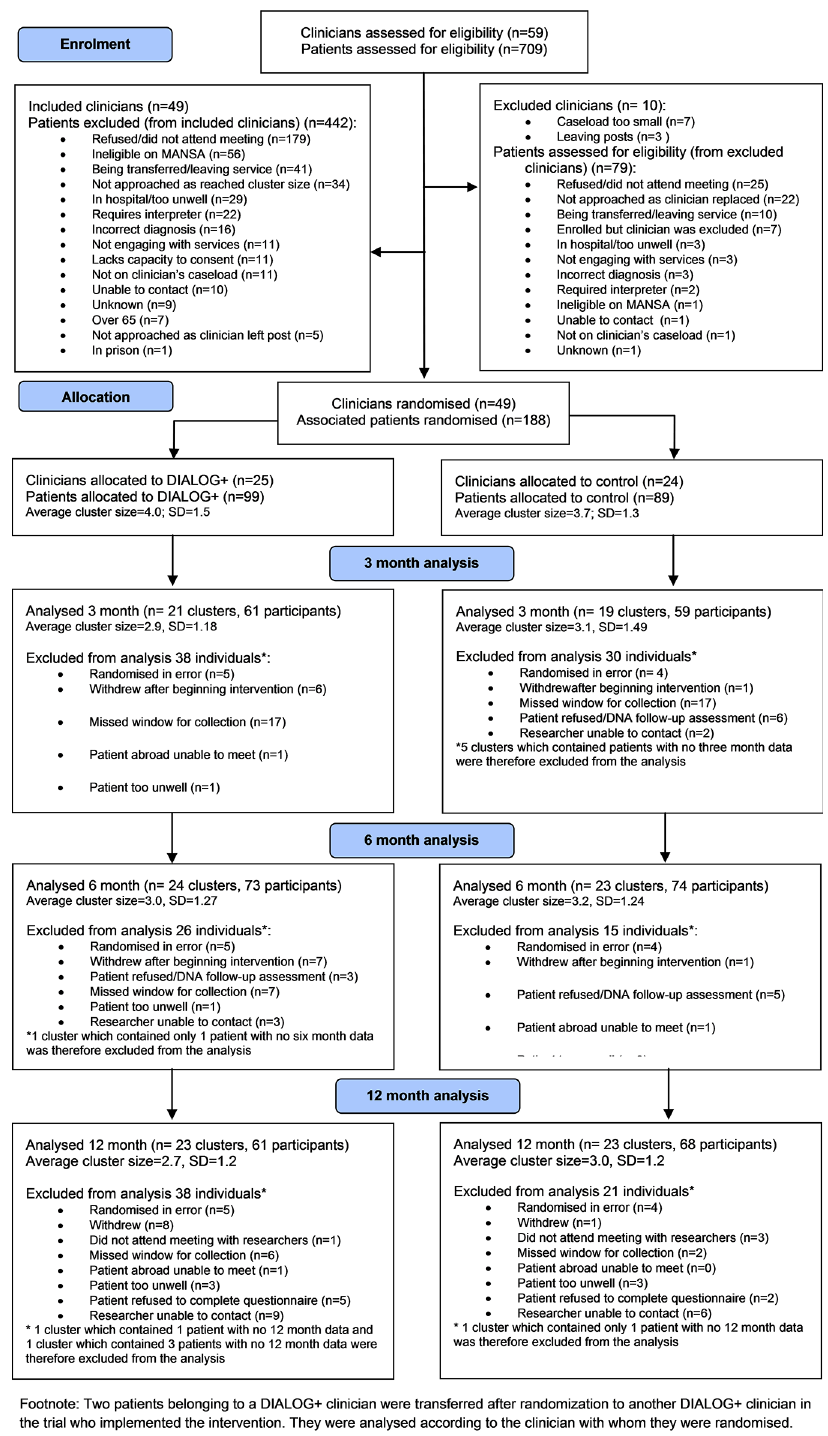
Fig 1. CONSORT flowchart.